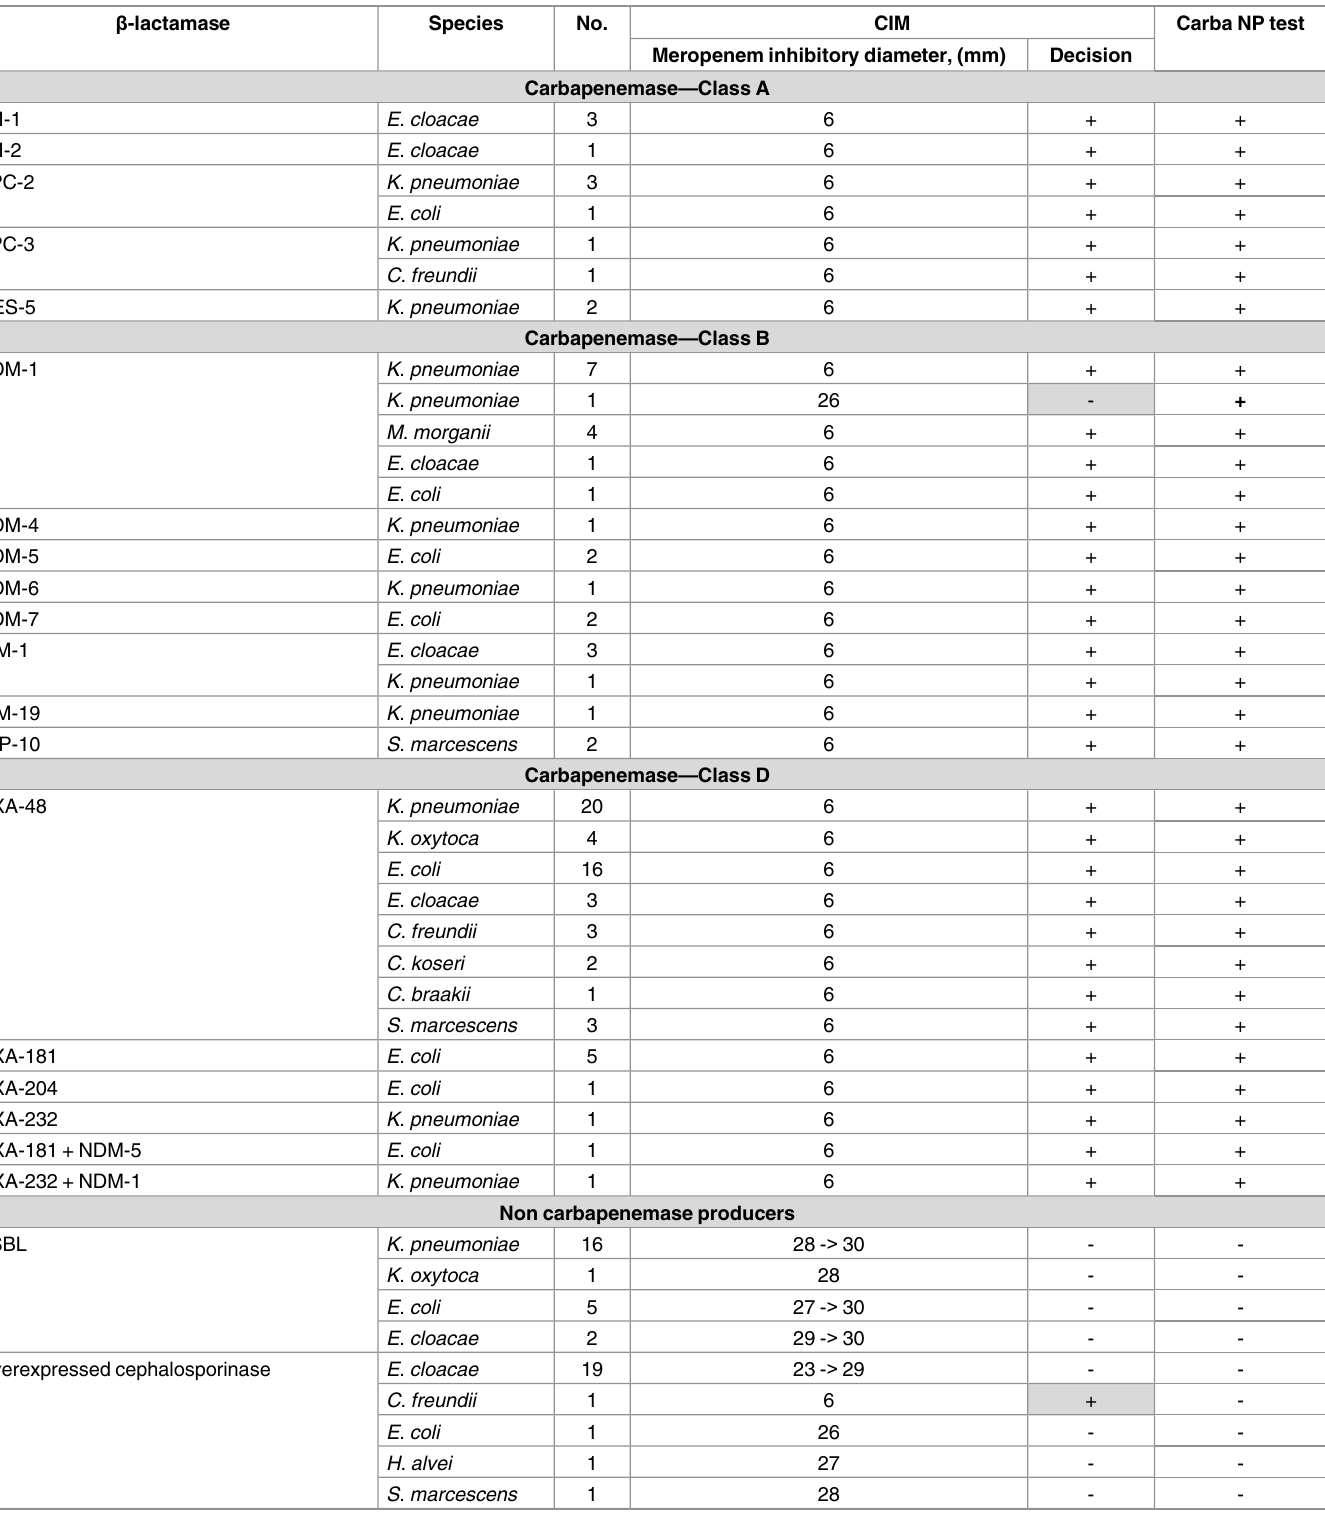
Table 3. Enterobacteriaceae isolates prospectively subjected to the CIM method, compared to the CarbaNPtest. β -lactamase